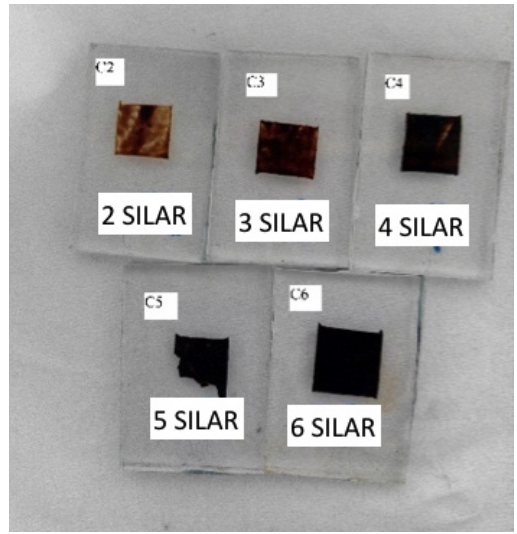
Figure 1: SnS QD-sensitized electrode sample. All samples show good film adhesion to the substrate despite irregular surface area.